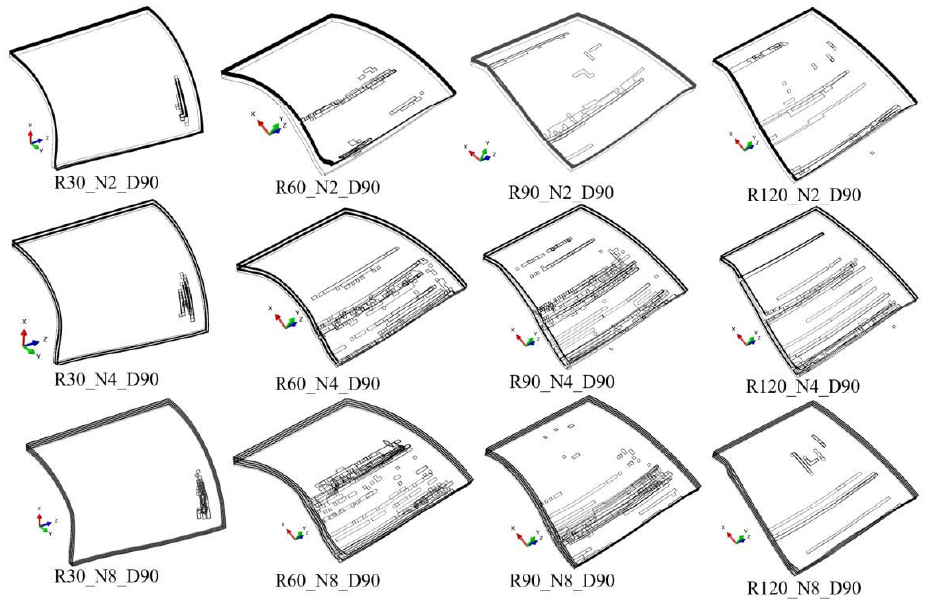
Figure 18. Influence of layers on CARALL deformation failure modes of curved surfaces.